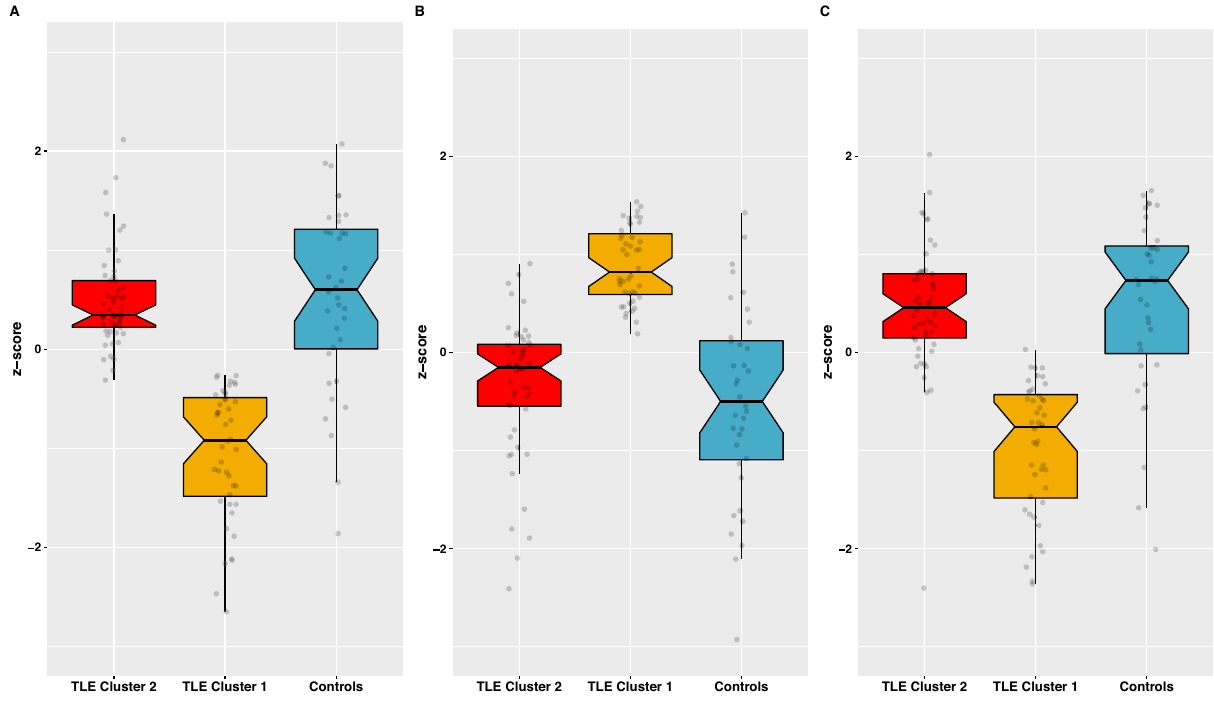
Figure 1. ( A ) Local efficiency, ( B ) Global efficiency, and ( C ) modularity index across ML-derived TLE clusters (red and yellow) and healthy controls (blue) for RS-fMRI.